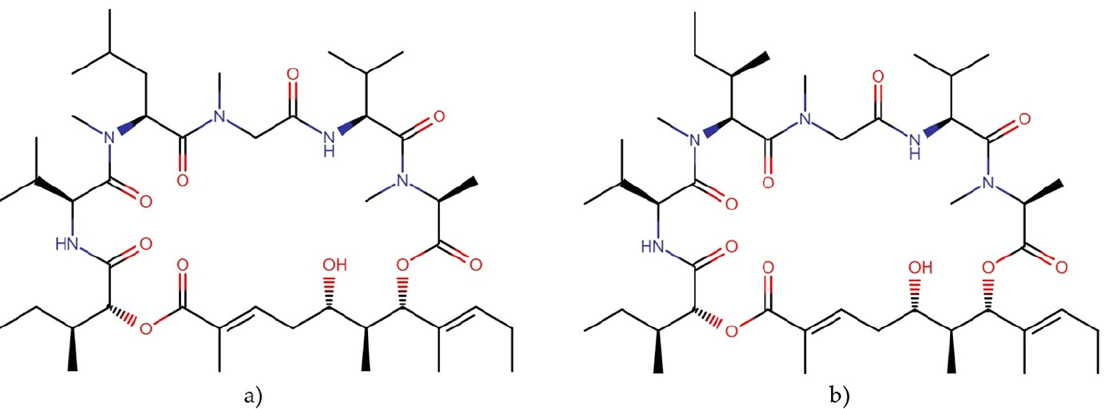
Figure 8. Chemical structures of ( a ) aurilide and ( b ) aurilide B. All molecules from this family are shown in Supplementary Figure S2.